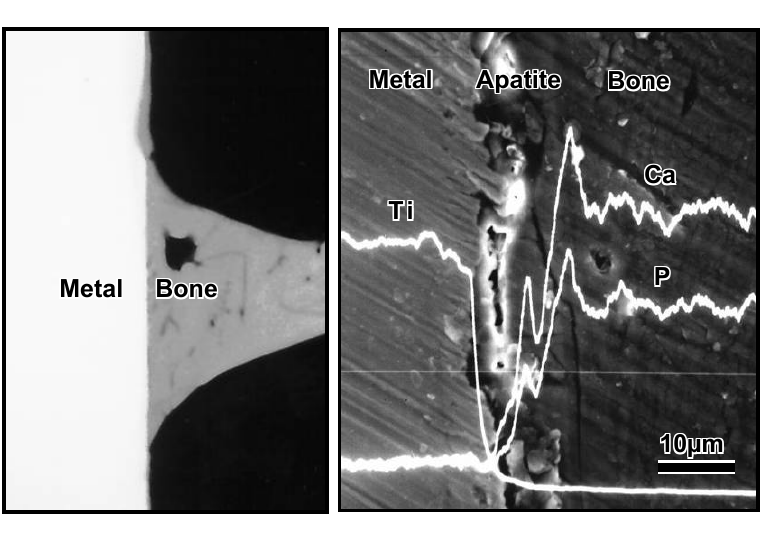
Figure 10. Detaching failure loads of the untreated and the NaOH- and heat-treated Ti metals as a function of implantation period in rabbit